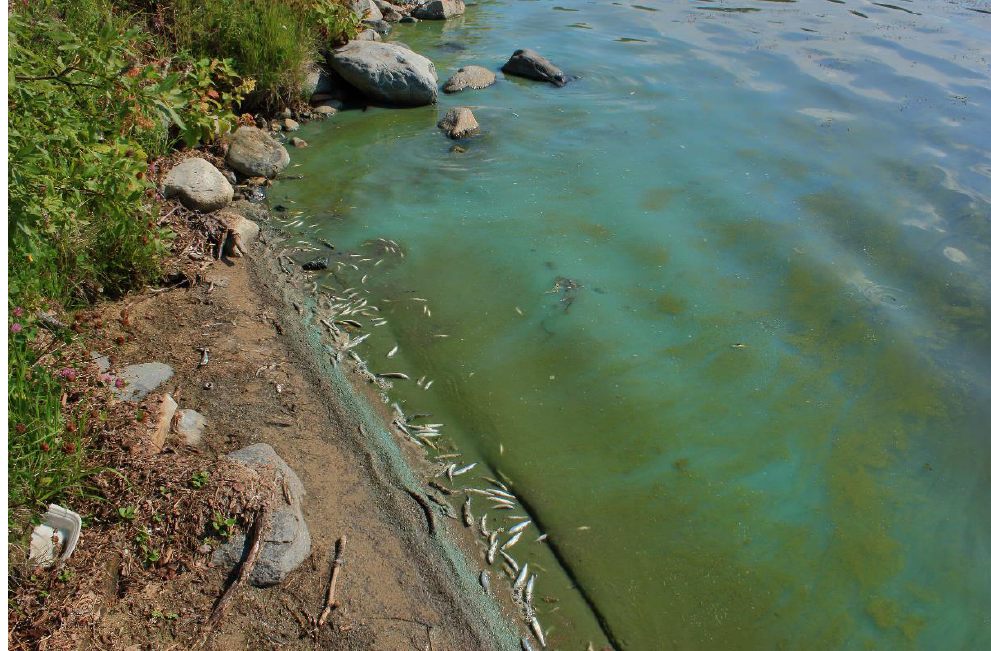
Figure 2. Dead fish during typical summer HAB formed by the simultaneous bloom of diatom — Dolichospermum sp. in Lake Imandra. The affected species include Coregonus lavaretus , Coregonus albula , Osmerus eperlanus of all life stages and juveniles of Perca fluviatilis .